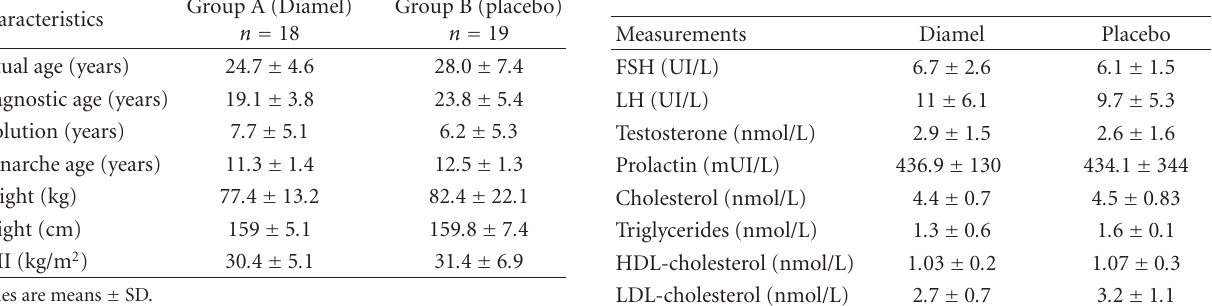
Table 2: Clinic characteristics in women with PCOS. Table 3: Hormone and lipid values in patients with PCOS taken at the start of the clinical